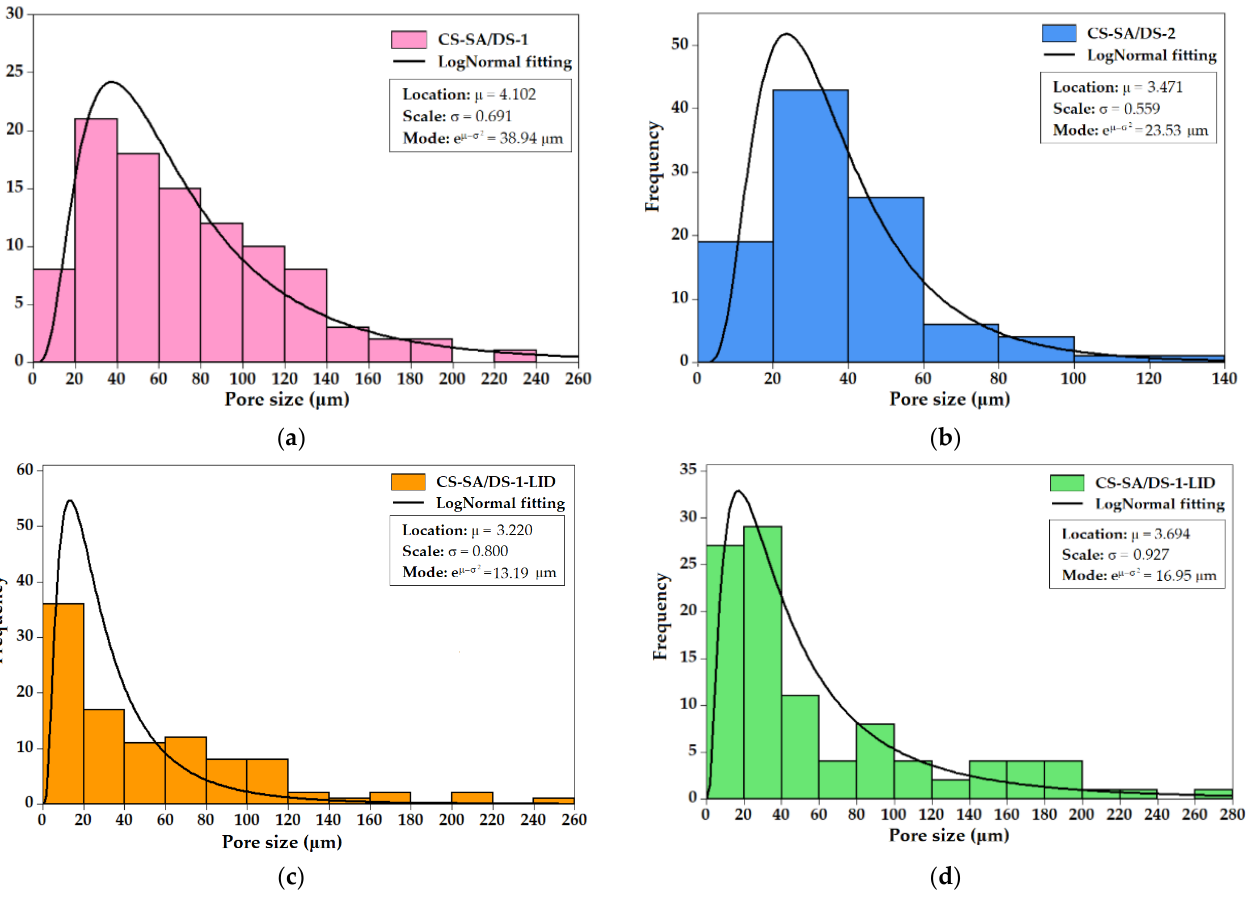
Figure 4. Histograms of pore distribution at the surface of: non-charged CS membranes ( a ) CS-SA/DS-1 and ( b ) CS-SA/DS-2; lidocaine-charged membranes ( c ) CS-SA/DS-1-LID and ( d ) CS-SA/DS-2-LID; the experimental data were fitted with LogNormal distribution function using Minitab 16 Software.